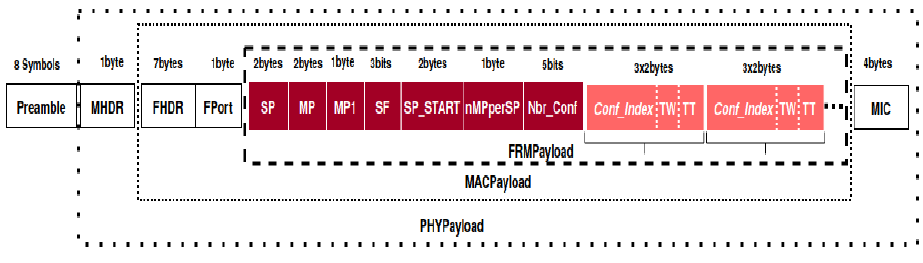
Figure 6. Format of a Configuration